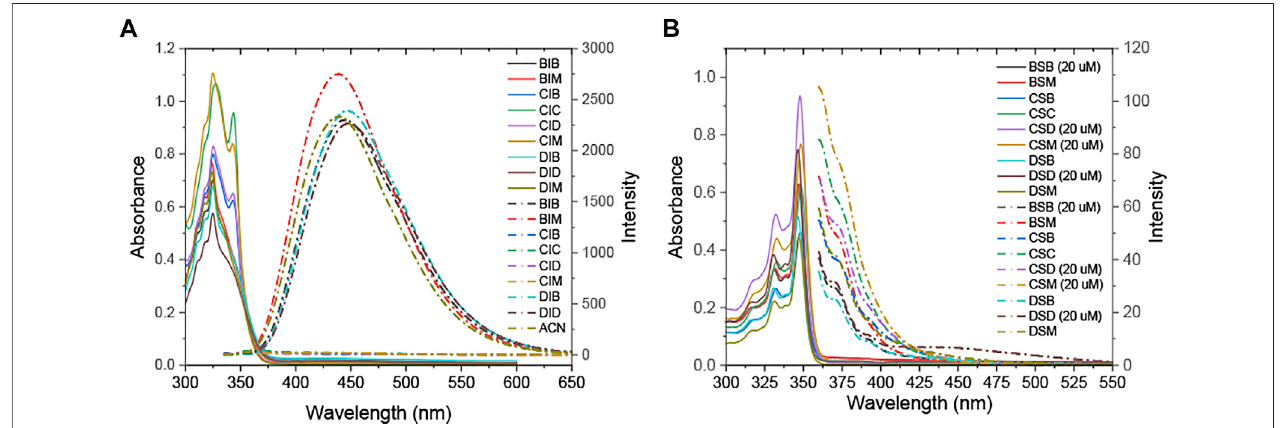
FIGURE 3 | UV – vis (solid line) and fl uorescence emission (dashed/dotted line) spectra of (A) R 1 IR 2 (80 µM) and (B) R 1 SR 2 (10 µM) (in ACN).